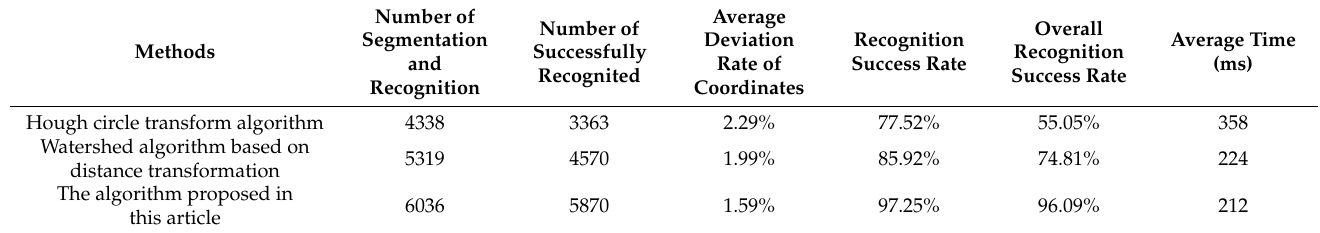
Table 2. Comparison of different algorithms for recognition of overlapping Agaricus bisporus